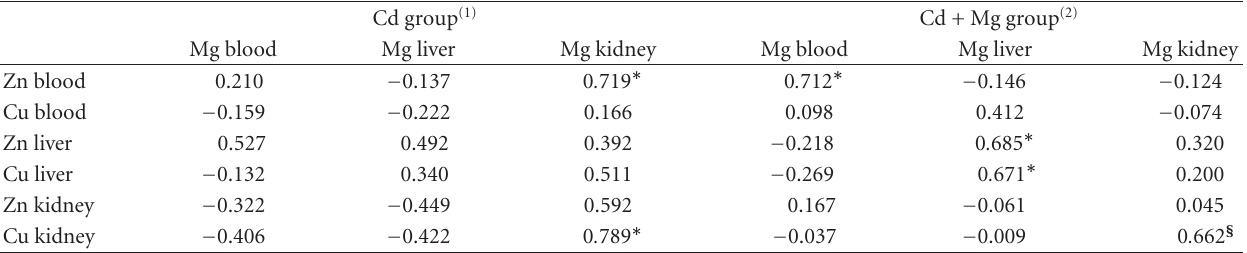
Table 3: Correlation coe ffi cients between the chosen indices of the body status of Zn, Cu, and Mg in animals treated per os with 10 mg Cd/kgb.w. and supplemented with 40mg Mg/kg b.w. daily for 4